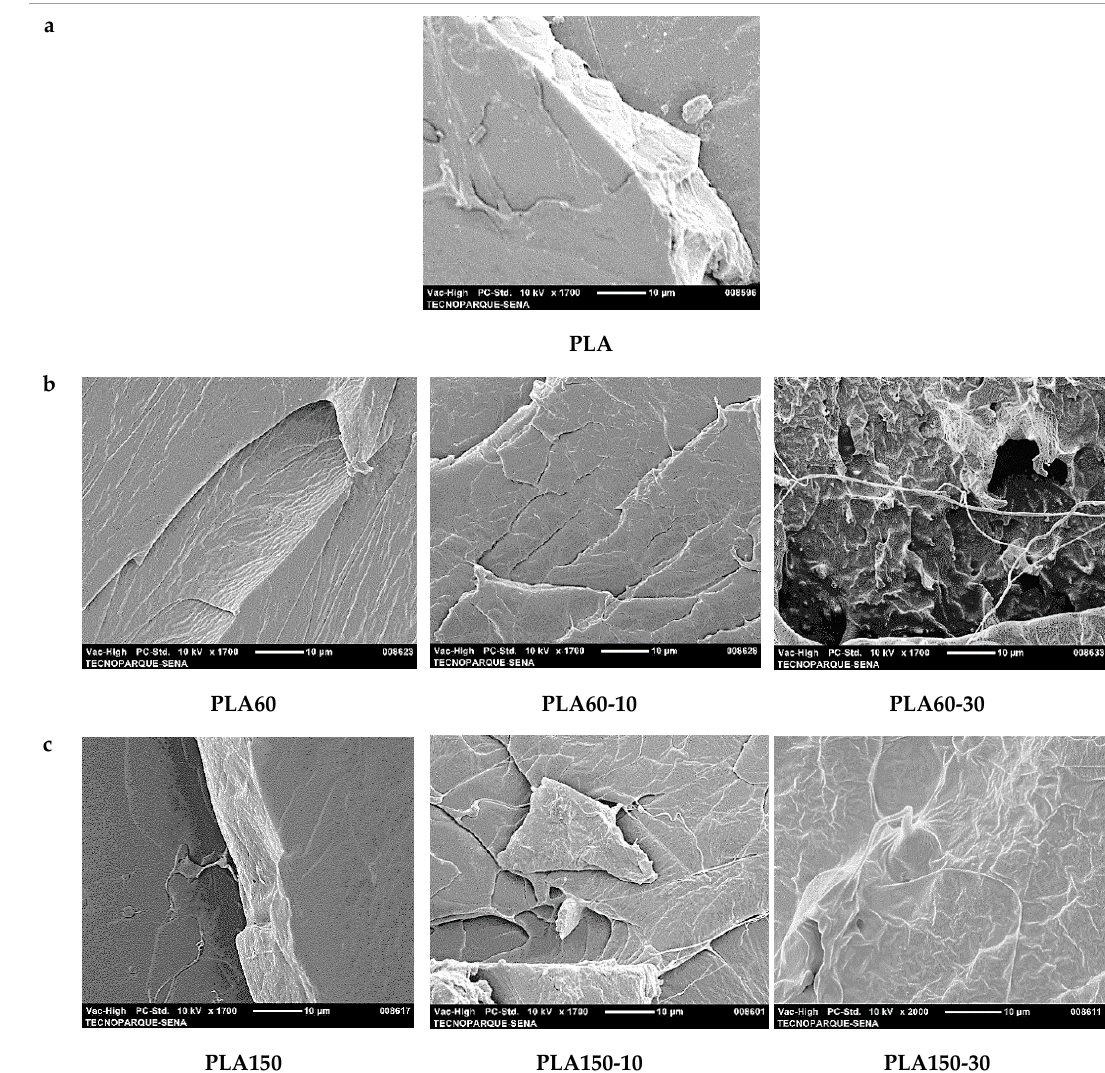
Figure 15. Micrographs obtained by scanning electron microscopy (SEM) with magnifications of 1700×for ( a ) PLA, ( b ) PLA60, PLA60-10 and PLA60-30, ( c ) PLA150, PLA150-10 and PLA150-30.